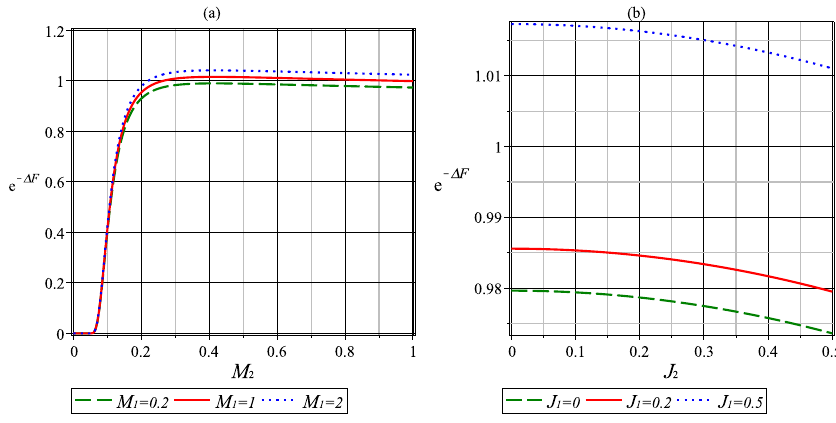
Figure 3 . e − ∆ F = Z 2 /Z 1 of the Myers-Perry black hole in terms of in terms of (a) final mass with η = 0 . 95 , J 1 = 0 . 1 , and J 2 = 0 . 2 ; (b) final angular momentum with η = 0 . 95 , M 1 = 0 . 5 , and M 2 = 1